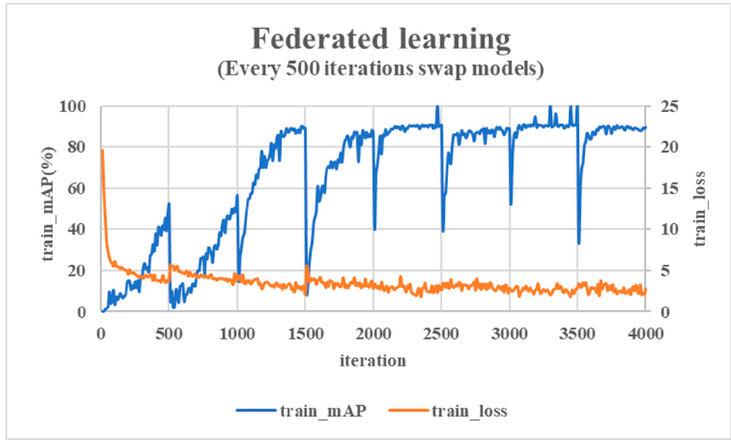
Figure 11. mAP and loss variation of the Los Angeles and Washington training data set.